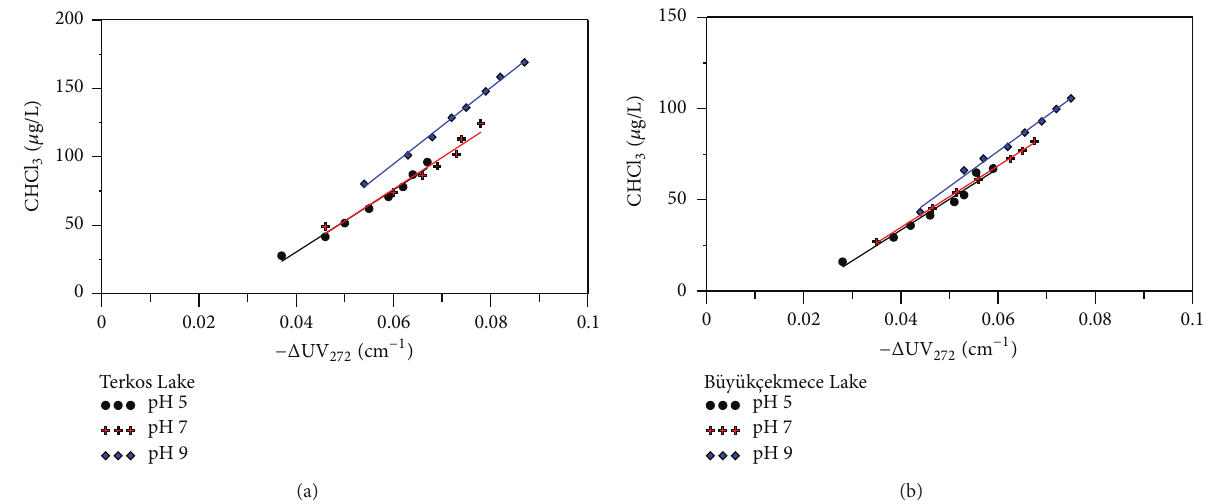
Figure 4: The relationship between CHCl 3 and Δ UV 272 at different pH (pH 5, pH7, and pH 9) and Cl 2 to DOC ratios from 0.8 to 3.2 (a) in chlorinated TL water and (b) for in chlorinated BL